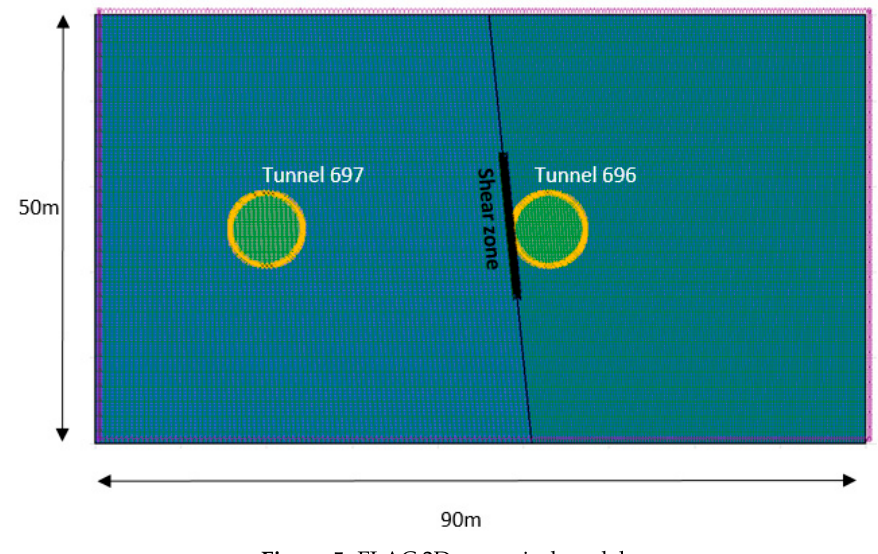
Figure 5. FLAC 2D numerical model.